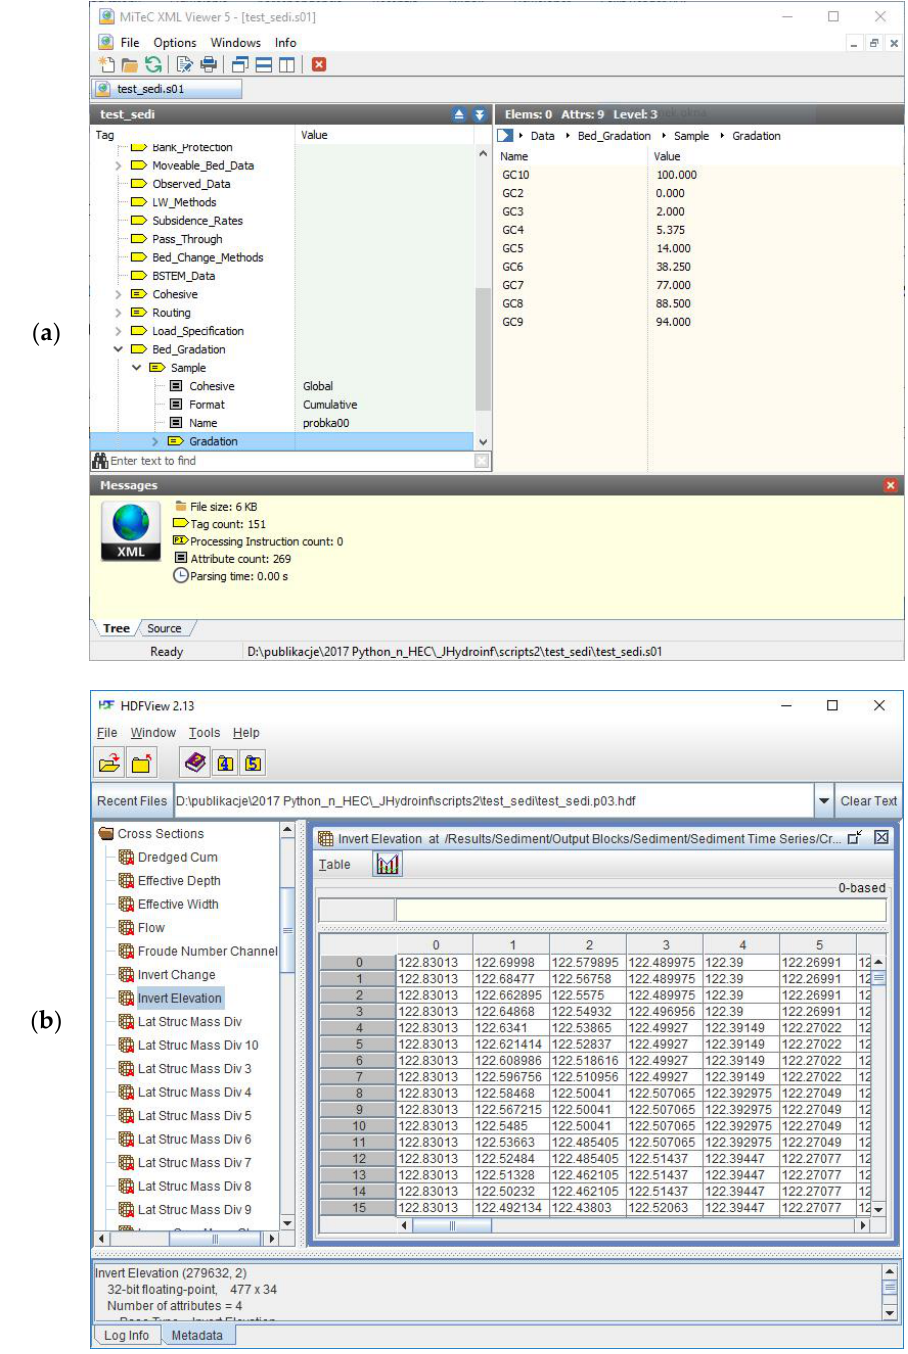
Figure 5. View of data and result files used in Example 3: ( a ) Sediment data file in XML Viewer, ( b ) sediment results in HDFViewer.